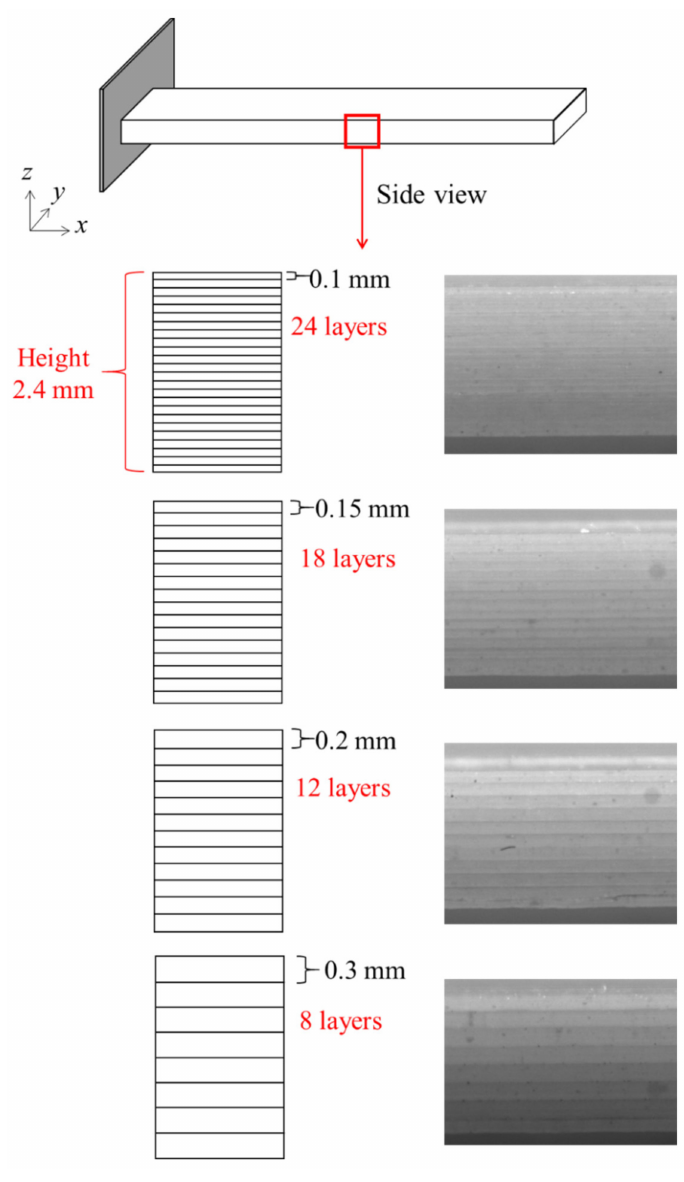
Figure 10. Schematic and photos of test pieces with different layer heights. In terms of printing parameters, the spacing between wire materials is set to be 0.4 mm. The x -axis and y -axis correspond to the length and width of the test piece, respectively. The raster angle is set to be θ = 0 ◦ , while the test piece is 166 × 24 × 2.4 mm 3 in size. As